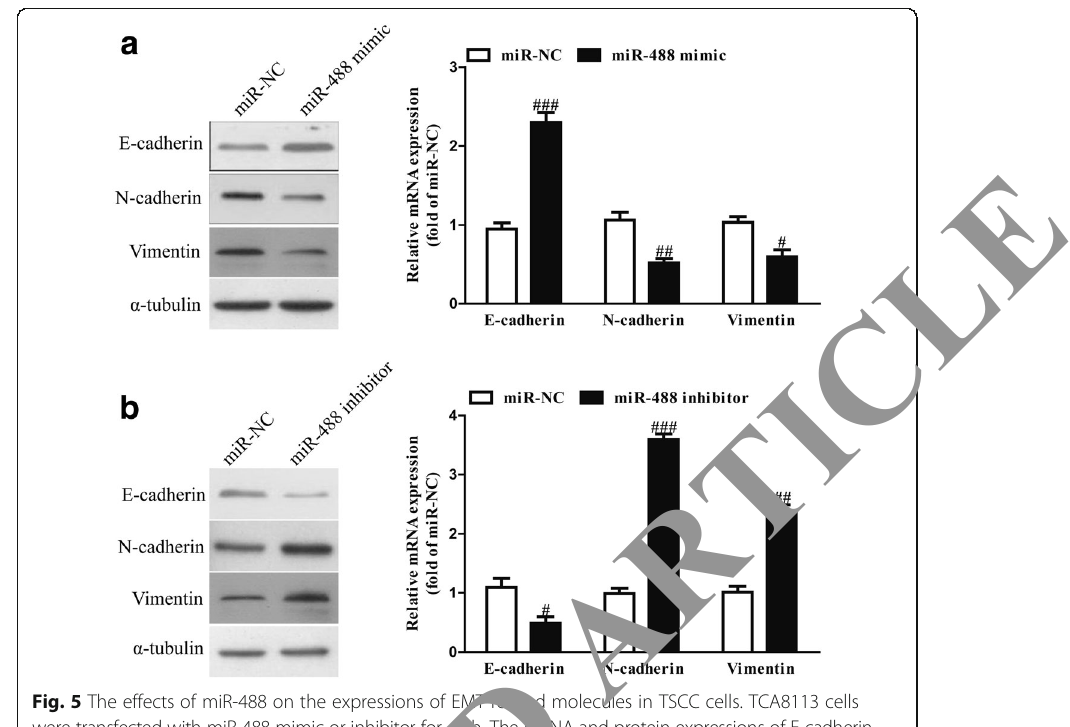
Fig. 5 The effects of miR-488 on the expressions of EMT-related molecules in TSCC cells. TCA8113 cells were transfected with miR-488 mimic or inhibitor for 48 h. The mRNA and protein expressions of E-cadherin, N-cadherin and vimentin were determined via quantitative RT-PCR and western blot, respectively. All data are presented as means ± SEM, n =6. # p <0.05, ## p <0.01, ### p <0.001 vs.